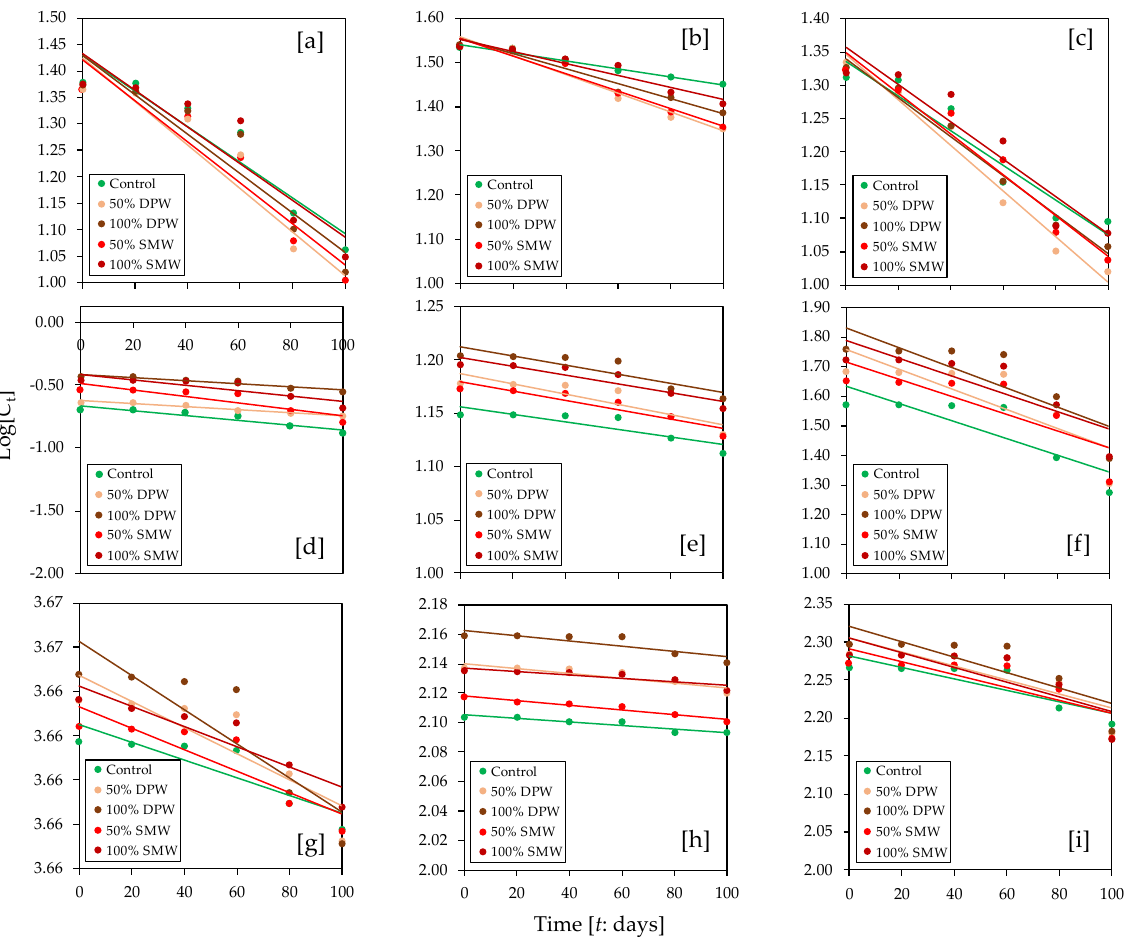
Figure 3. Time-course fitness plots (Log[ C t ] vs. time [ t ]) using a first-order kinetic model for reduction of substrate parameters by Shiitake ( L. edodes ) mushroom [( a ): lignin; ( b ): cellulose; ( c ): hemicellulose; ( d ): Cd; ( e ): Cu; ( f ): Cr; ( g ): Fe; ( h ): Mn; ( i ): Zn].